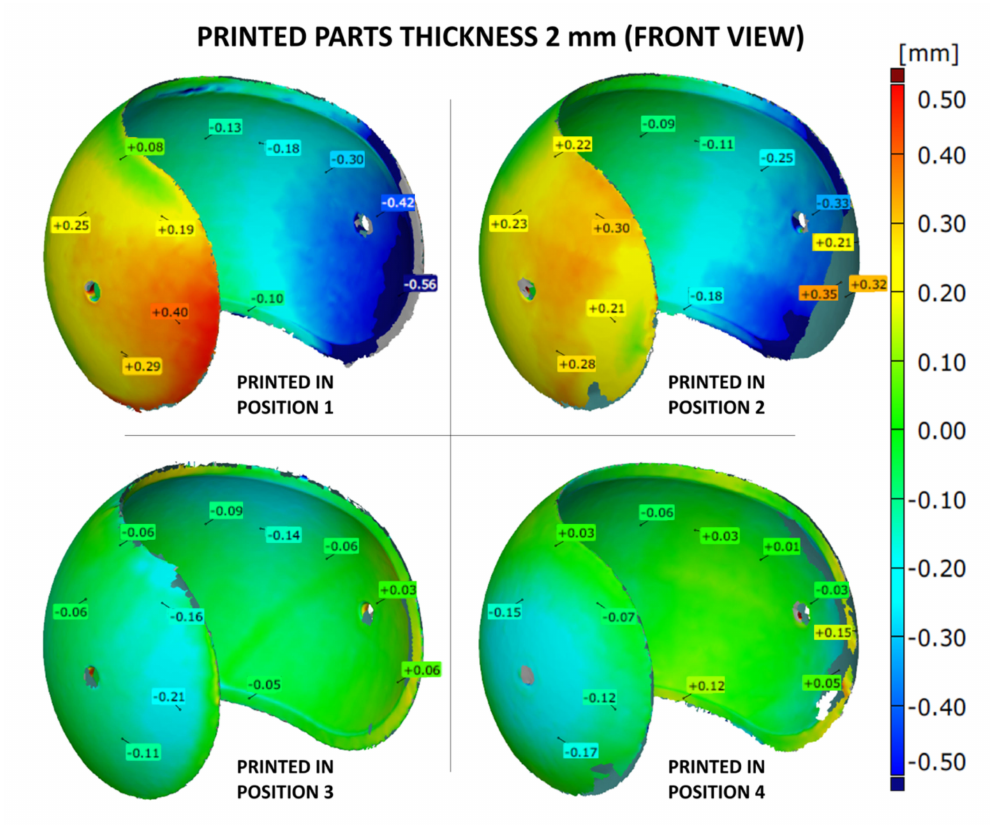
Figure 9. Geometry deviations of the 3D printed part with a thickness of 2 mm (front